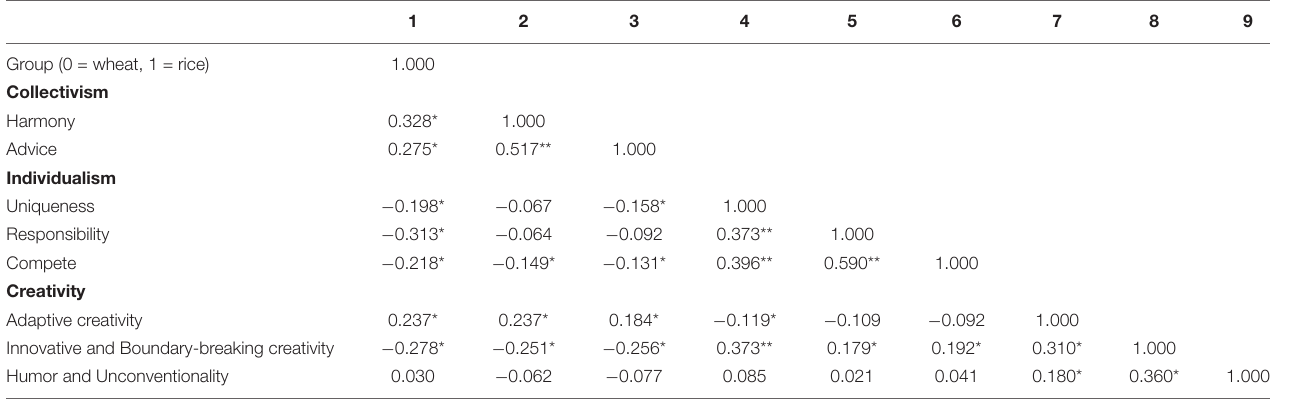
TABLE 6 | Bivariate correlation between